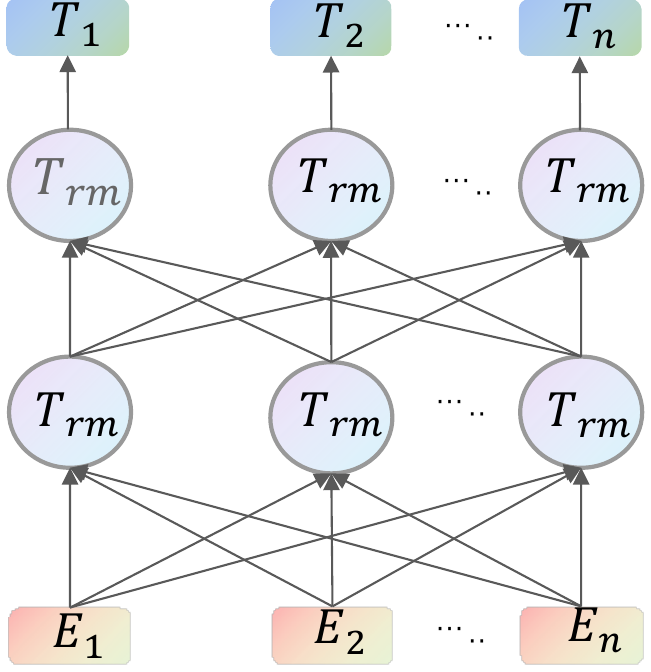
Figure 6. BERT multilayer bidirectional transformer encoder.